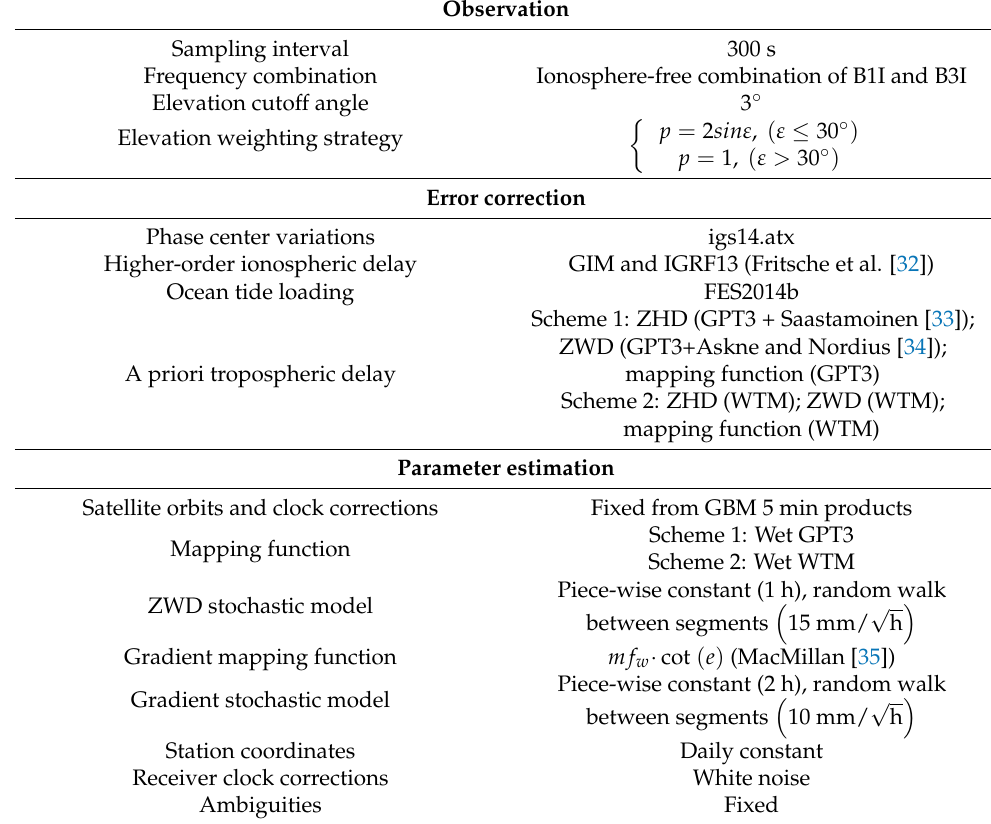
Table 3. Data processing strategies for BDS